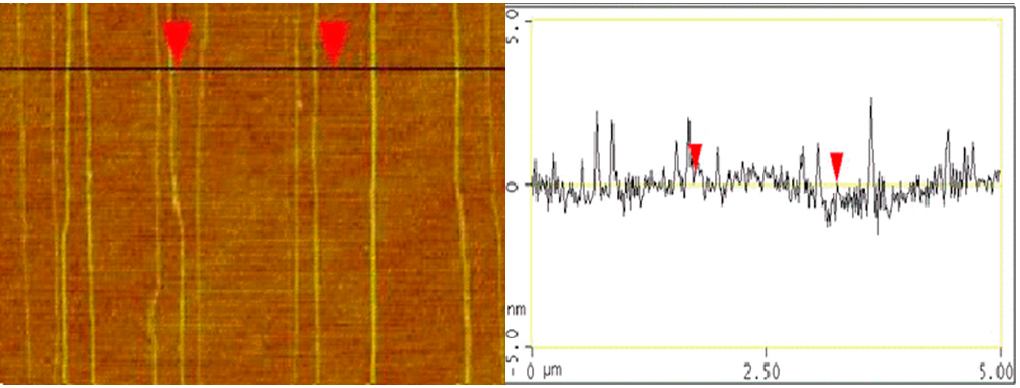
Figure 4. Atomic force microscopy image and the corresponding section analysis of horizontally aligned carbon nanotubes on quartz substrate.